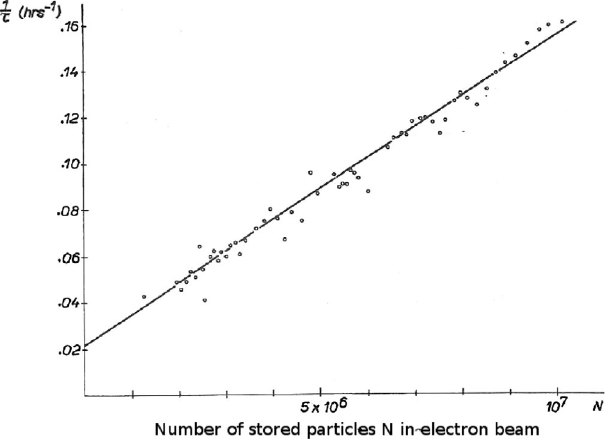
FIG. 1. First measurement of the Touschek effect in 1963 [14]. Inverse lifetime 1 versus N , the number of stored particles in the τ beam, at energy E ¼ 188